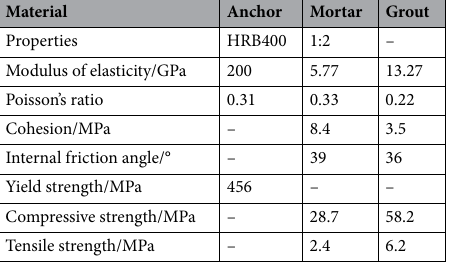
Table 2. Rock mechanical parameters of pull-out test materials.